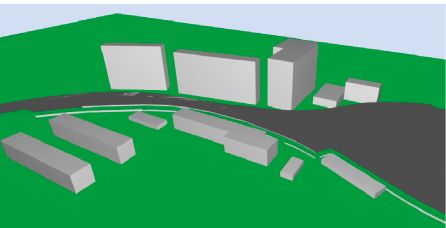
Figure 14: The 3D model of considered area established by CadnaA. Table 3: The maximum A-weighted sound pressure level per each pass-by.